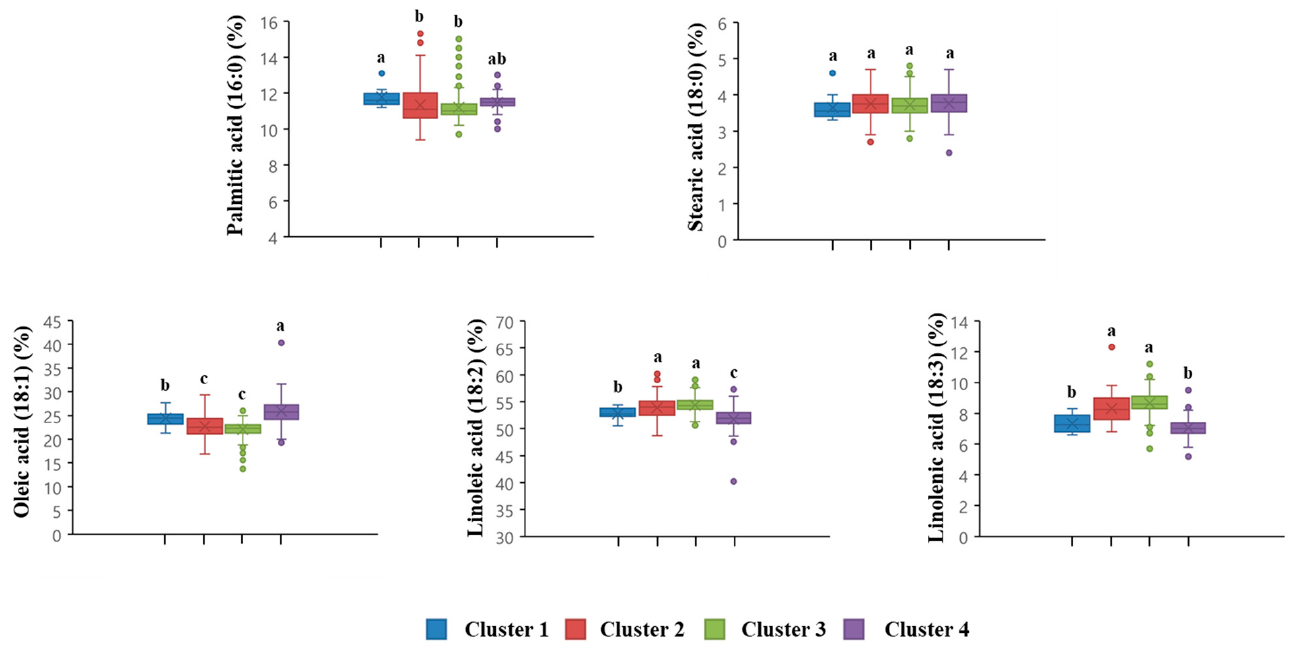
Figure 5. Box plots of fatty acids in 4 clusters of 468 black soybean germplasms with green cotyledons, including check cultivars ‘Cheongja 3’ and ‘Cheongja’. The letters above the bars are statistically different based on the least square difference.